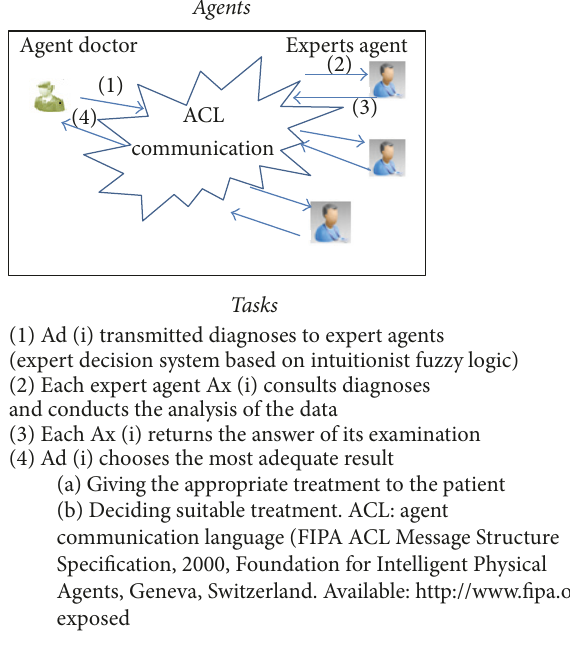
Figure 1: Agent (doctor and expert)